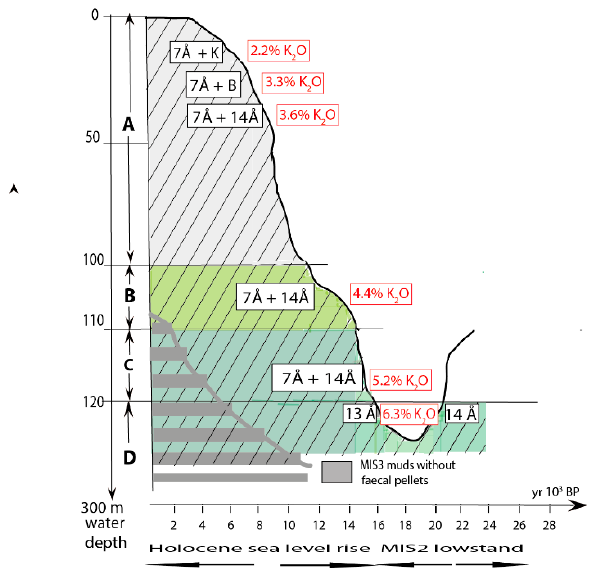
Figure 8. Mineralogical and geochemical evolution observed on the shelf of Congo River from the coast out to sea. An increasing age of the sediment and, therefore, of maturation of the grains is identified through phases A, B, C, and D. Partly redrawn from [1,2,27]. Phase A . These are the most littoral muds to have been deposited recently; they are mainly above 50 m in water depth from the active fluxes of the Congo River. A TeOc struc- ture close to beidellite appeared over a fairly short time, estimated at4 to 5000 years.